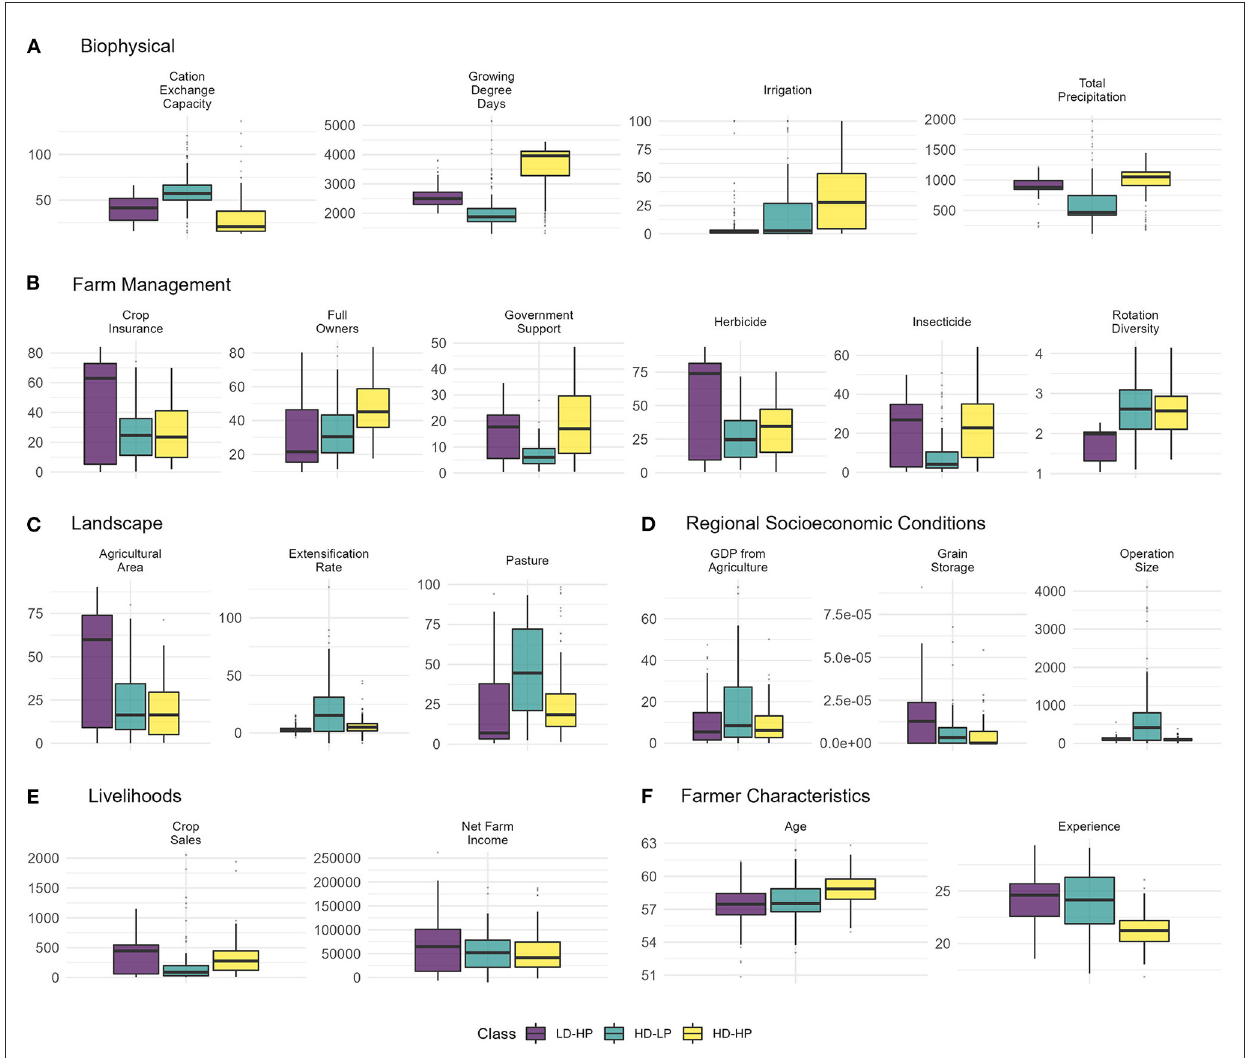
FIGURE5 (A–F) Select box and whiskers plots comparing agricultural system attributes across LD-HP, HD-LP, and HD-HP for archetypal